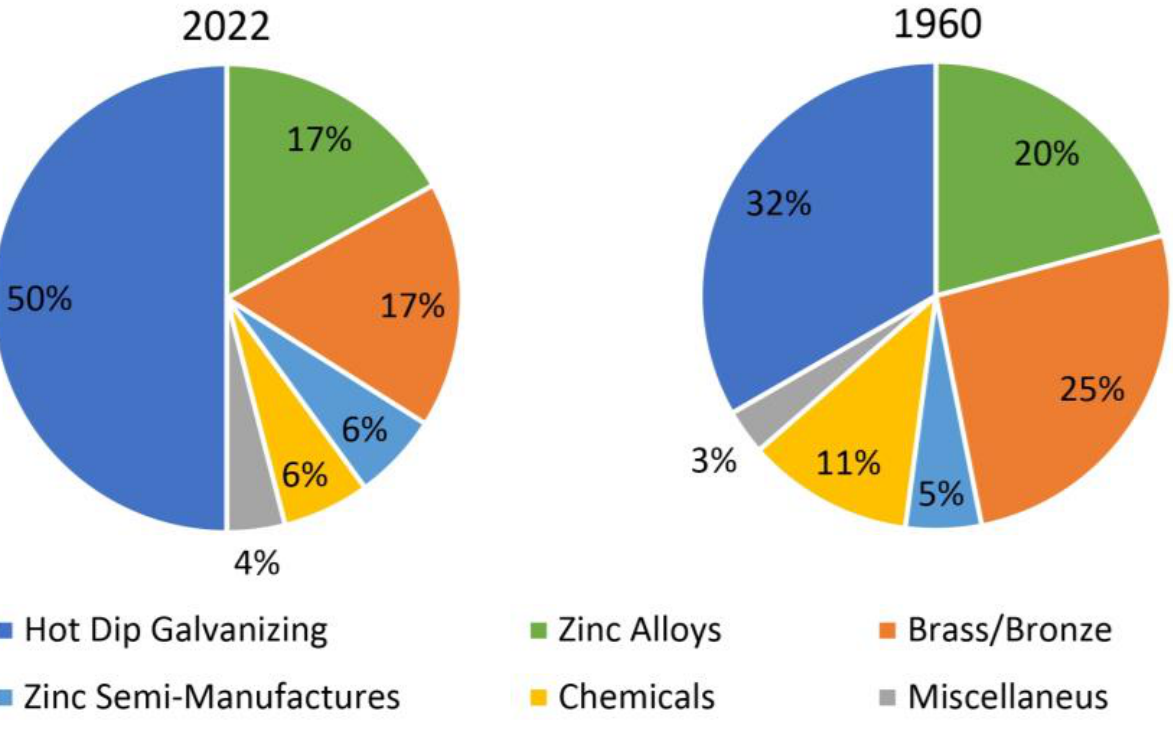
Figure 4. End use zinc consumption distribution in 1960 and 2022, figure worked out on data taken from [28].